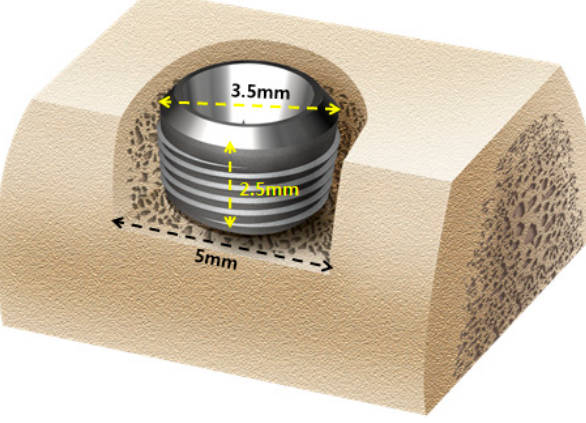
Figure 2. Schematic diagram of the open buccal defect model; 4.5 mm of the implant was installed inside the reduced alveolar ridge up to the reference notch, to form 2.5 mm supra-alveolar, peri-implant defects.